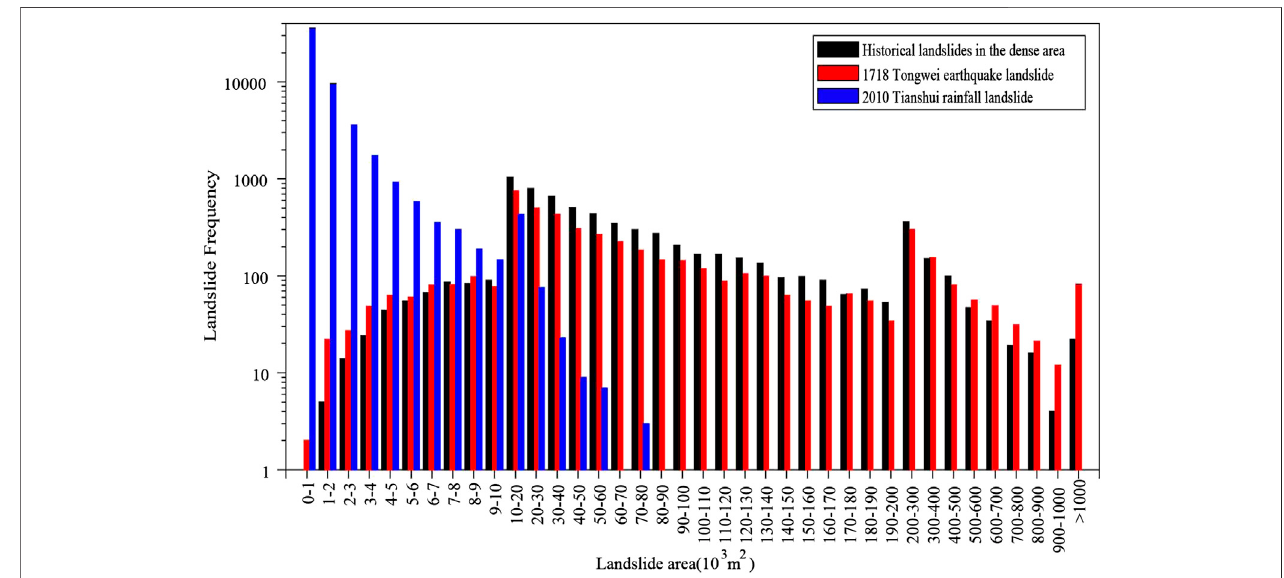
FIGURE 9 | Comparison of the dominant area of the rainfall landslide and the 1718 Tongwei earthquake landslide (Xu et al., 2020a; Xu et al., 2020b) and the historical landslide area in Long County, Qishan